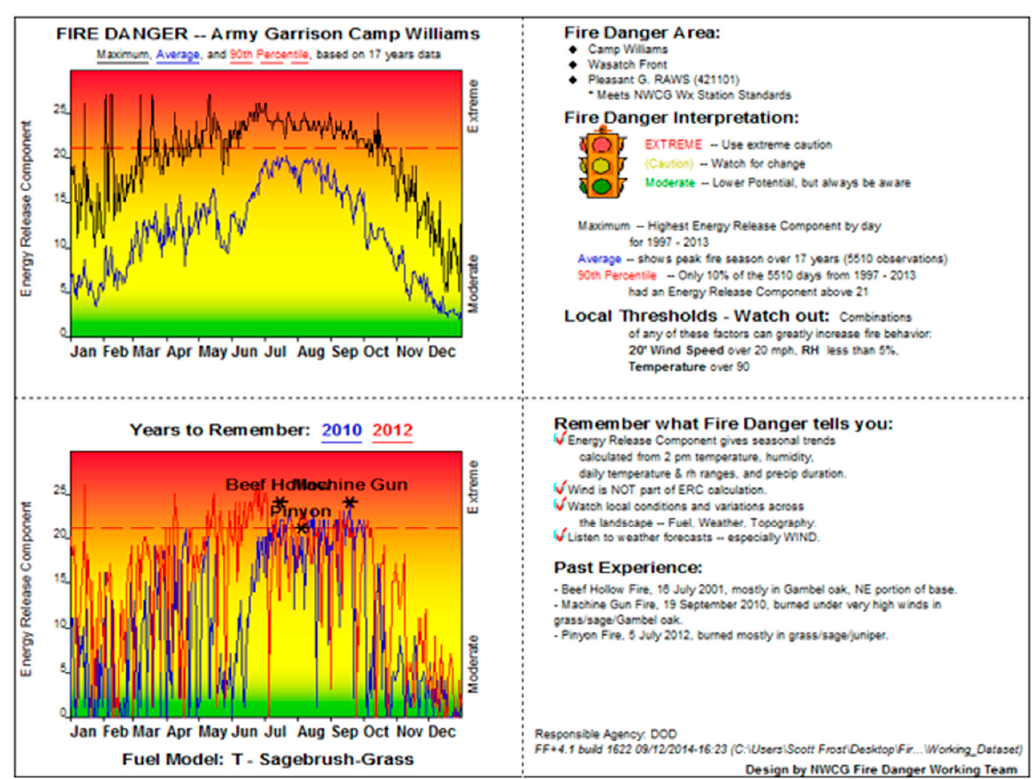
Figure A1. Fire danger rating pocket card, produced from remote automatic weather station (RAWS) climatological data recorded near Army Garrison Camp Williams. 90 th percentile Energy Release Component are displayed as a red-dotted line. On the bottom plot, two specific years when large fires occurred in 2010 (Machine Gun Fire) and 2012 (Pinyon Fire) are displayed.